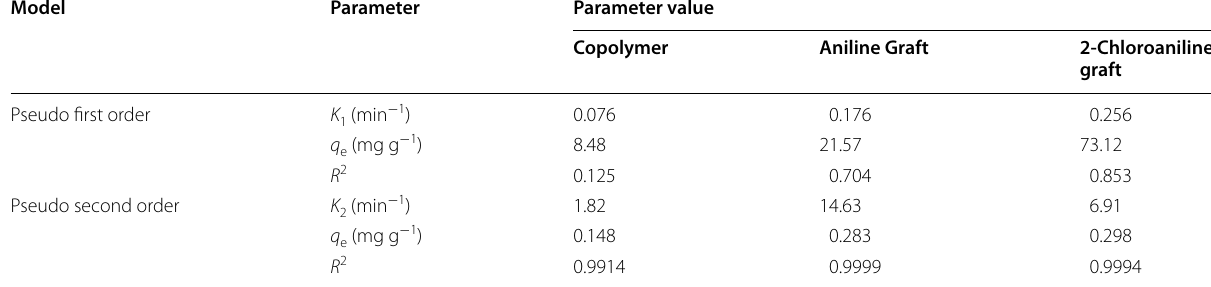
Table 6 Kinetic models data Model Parameter Parameter